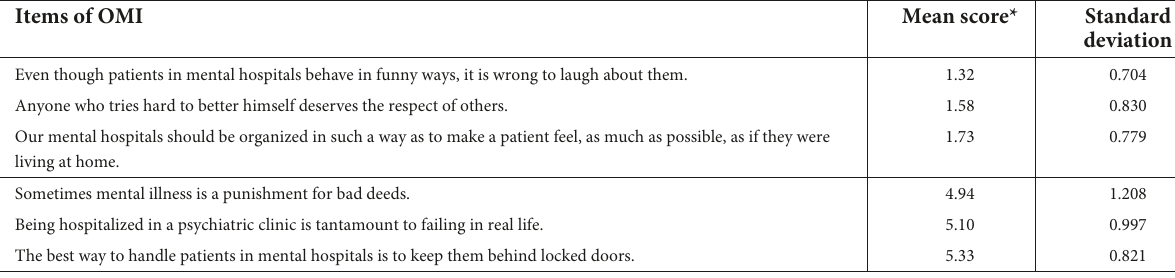
TABLE 1 Items of maximum and minimum mean scores in OMI analysis. Items of OMI Mean score* Standard